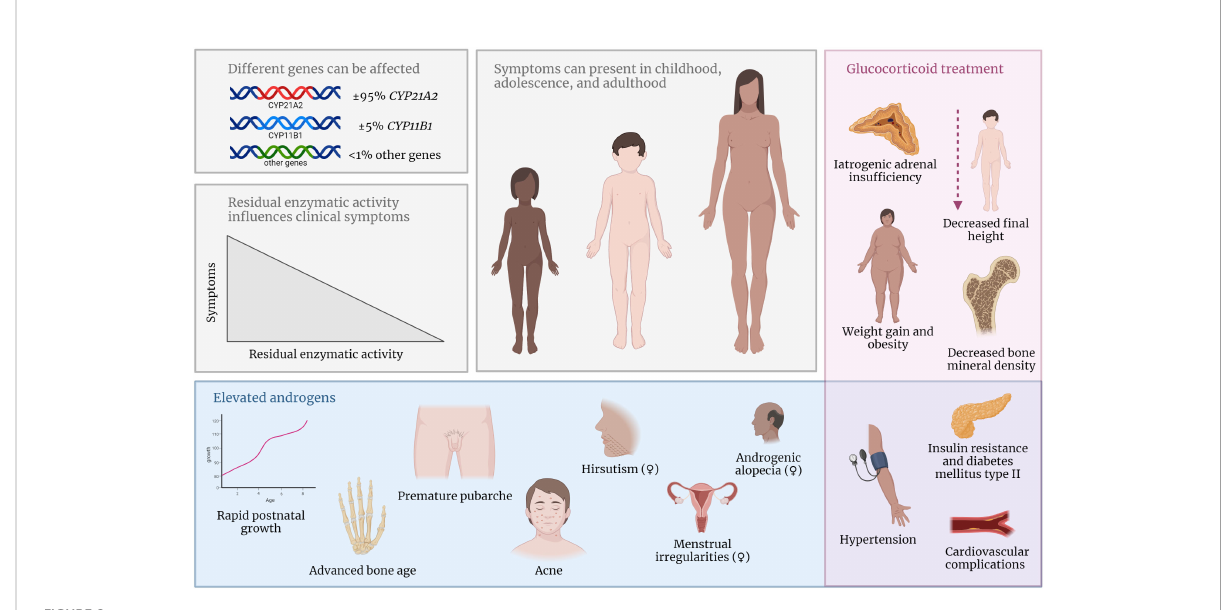
FIGURE 2 In NCCAH, different gene mutations can lead to decreased activity of the effected enzyme. Symptoms can present during childhood, adolescence, and adulthood and are in fl uenced by the residual enzymatic activity. Elevated androgen concentrations can lead to various clinical symptoms (blue box). Side effects of supraphysiological glucocorticoid treatment are common (red box). Symptoms in the purple box occur due to elevated androgens or glucocorticoid